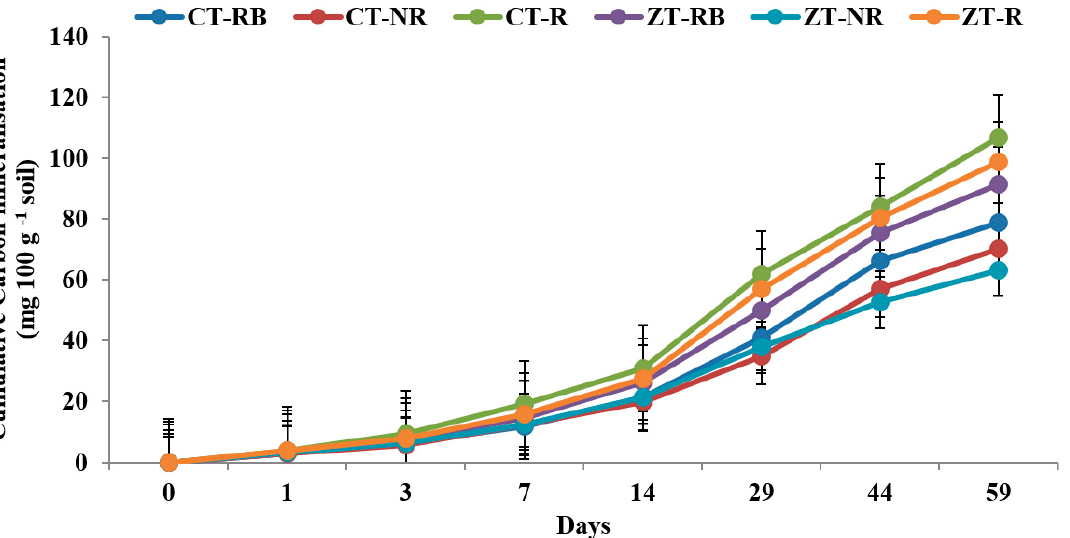
Figure 4. Cumulative carbon mineralization (mg 100 g − 1 soil) from macro-aggregate in 0–5 cm depths as affected by 18 years of tillage and residue management in a rice–wheat cropping system in an Inceptisol at 27 °C. ZT = zero tillage; CT = conventional tillage; NR = no residue; RB = residue burning; R = residue retention. Error bars identify LSD ( p ≤ 0.05) of different treatments.